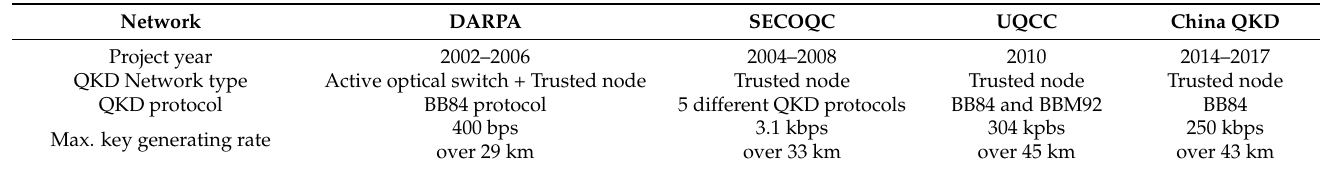
Table 1. Summary of QKD network